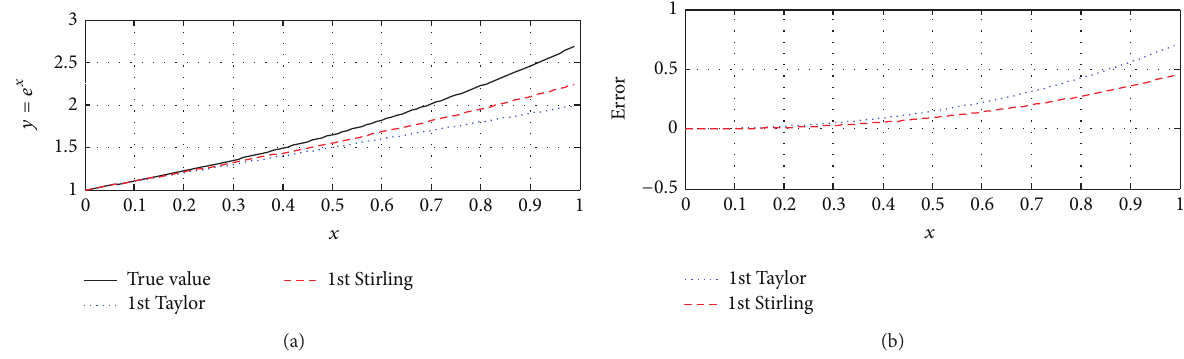
Figure 1: Comparison of first-order Stirling series with first-order Taylor series